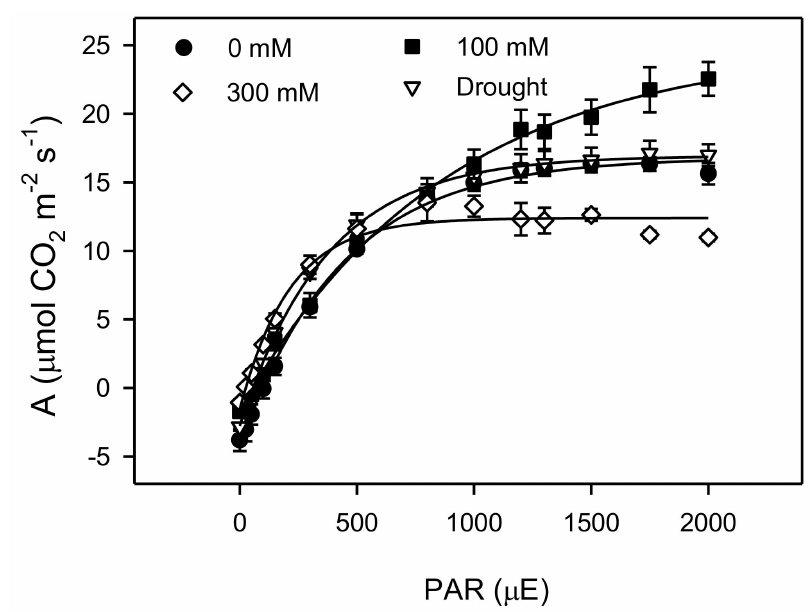
Figure 2. Light response curve between the net photosynthesis (A) and light intensities (PAR; 0–2500 µ mol photon m − 2 s − 1 ) on leaves of Phragmites karka under 0, 100, and 300 mM NaCl and drought.